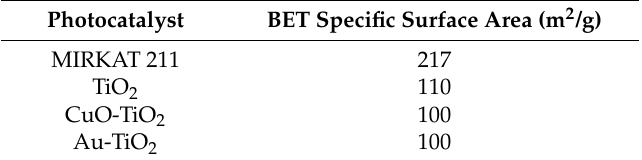
Table 1. Specific Surface Areas of the examined photocatalysts obtained by N 2 physisorption